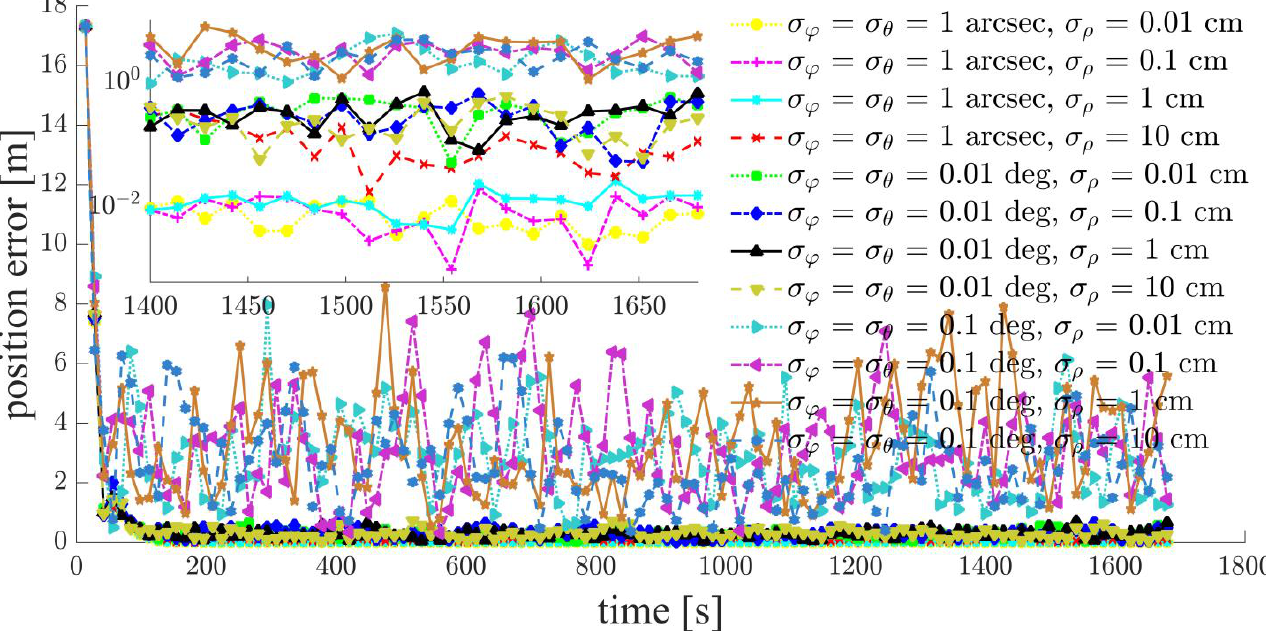
Figure 15. Relative navigation errors of 𝑆 5 (simulated scenario: Case d, space-circle formation radius of 1 km).